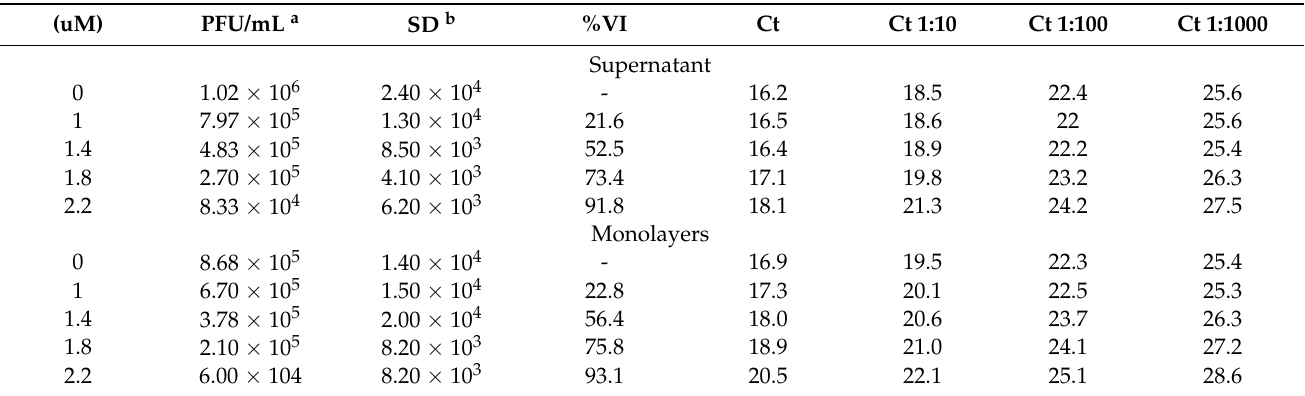
Table 2. TIZ antiviral activity on DENV-2 replication in Vero cell supernatant and into cells after viral infection by real-time plate and RT-PCR assay.